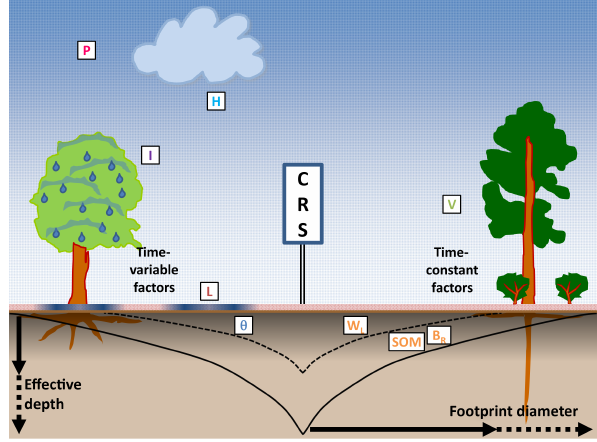
Figure 2. Simplified representation of factors influencing the raw neutron count and the measurement support volume of the CRS in terms of effective measurement depth and footprint. Temporally variable factors are shown on the left: barometric pressure ( P ), canopy interception ( I ), air humidity ( H ) and litter layer intercep- tion ( L ). Temporally constant factors (for our study site) are shown on the right: vegetation above and below the sensor ( V ), soil or- ganic matter (SOM), root biomass ( B R ) and lattice water ( W L ). All these factors need to be accounted for in order to isolate the soil wa- ter content signal ( θ ). The time-variable factors require permanent monitoring and dynamic correction, the influence of the constant factors is taken into account during calibration. The combination of time-variable and time-constant factors leads to a reduction of the maximum effective depth and footprint diameter (solid black line) and creates a site-specific temporally variable effective mea- surement depth and footprint diameter (dashed black